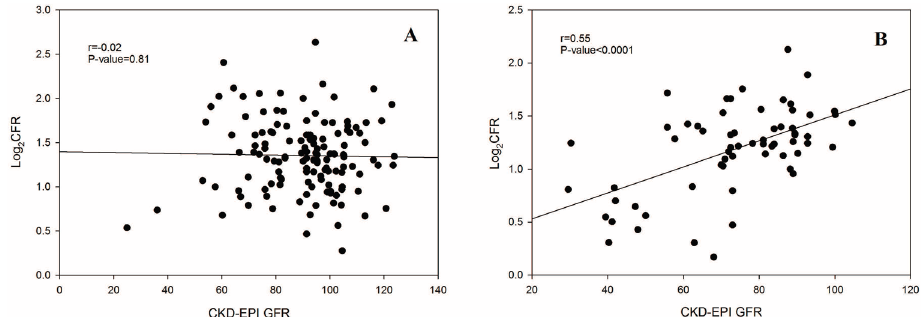
was determined using the Chronic Kidney Disease Epidemiology Collaboration (CKD-EPI)